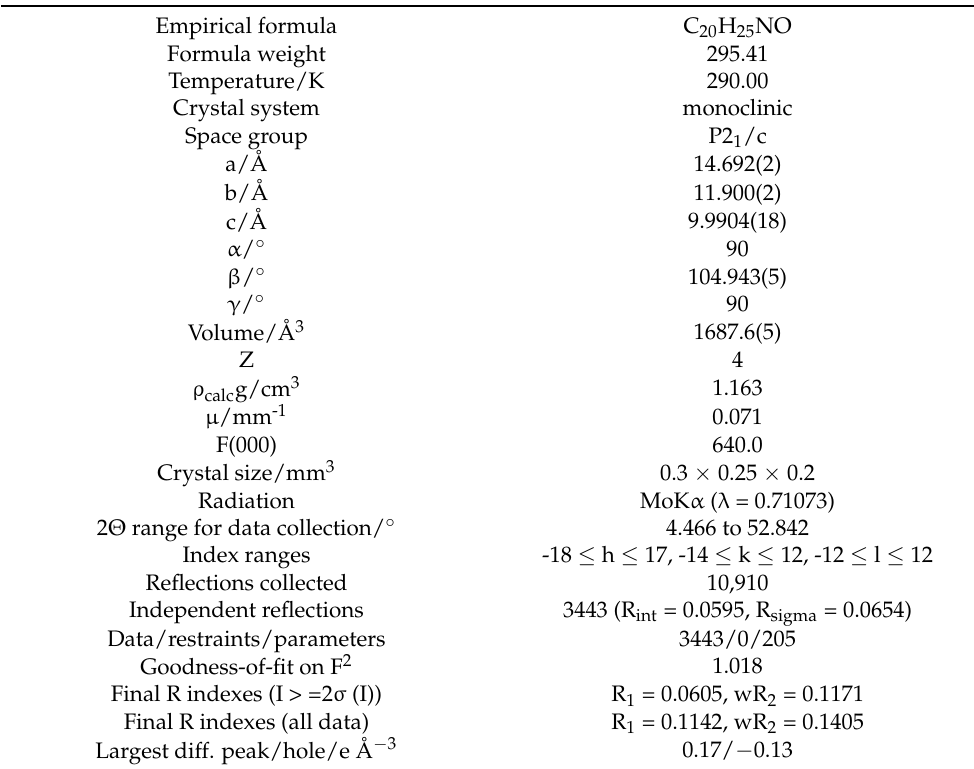
Table 1. The most important data collection and crystallographic refinement parameters for (E)=N-(2- methylcinnamoyl)-amantadine.